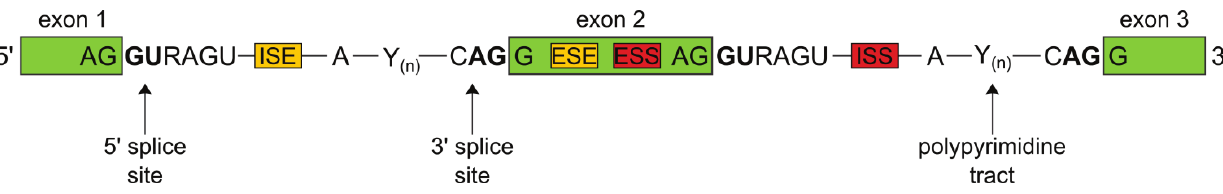
Figure 1. Splicing signals involved in pre-mRNA splicing. Introns are delineated by short consensus sequences, the 5' and 3' splice sites (R = Purine, A/G), the polypyrimidine tract (Y = Pyrimidine, C/T), and the branch point sequence. Intronic splicing silencers (ISS), intronic splicing enhancers (ISE), exonic splicing silencers (ESS), and exonic splicing enhancers (ESE) are additional sequence elements serving as docking sites for protein factors that promote or impair assembly of the spliceosome at particular splice sites and thus control the splicing process. The green boxes denote exons. Introns are represented by lines with the consensus sequences indicated (see text for